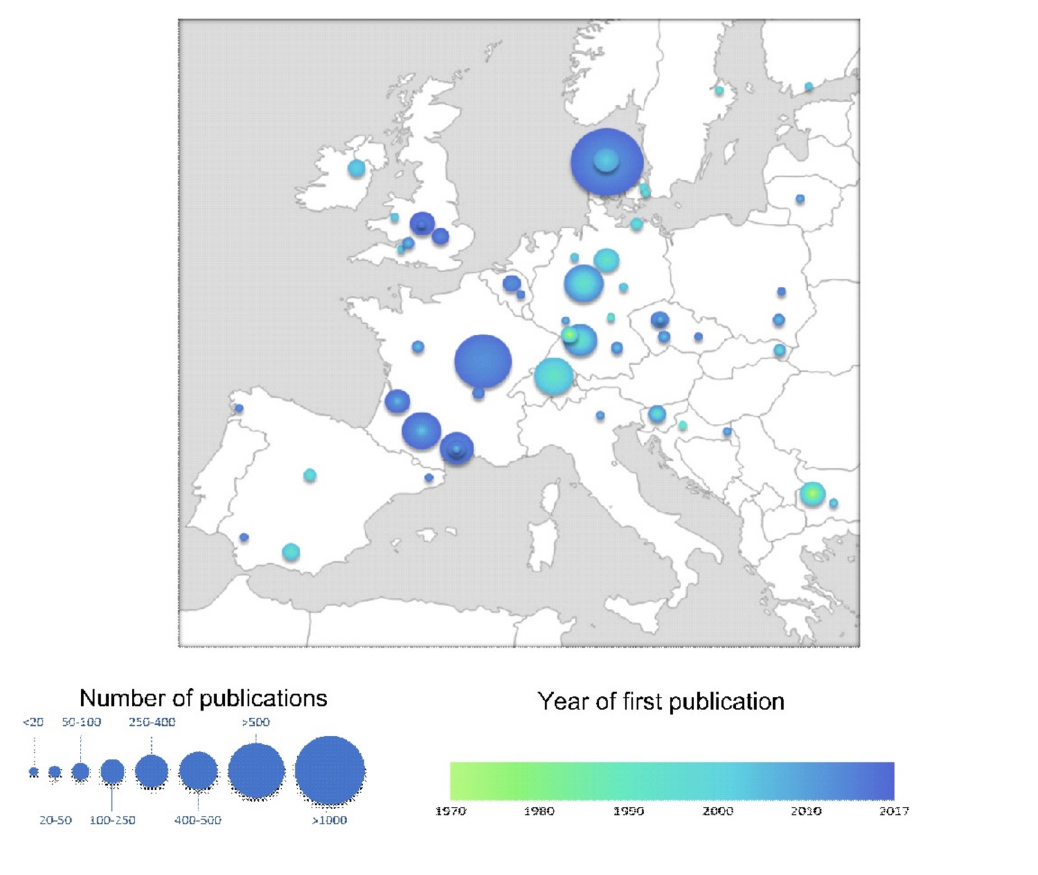
Figure 4: Dynamic of activity of research actors on agroecology (1971-2017 in